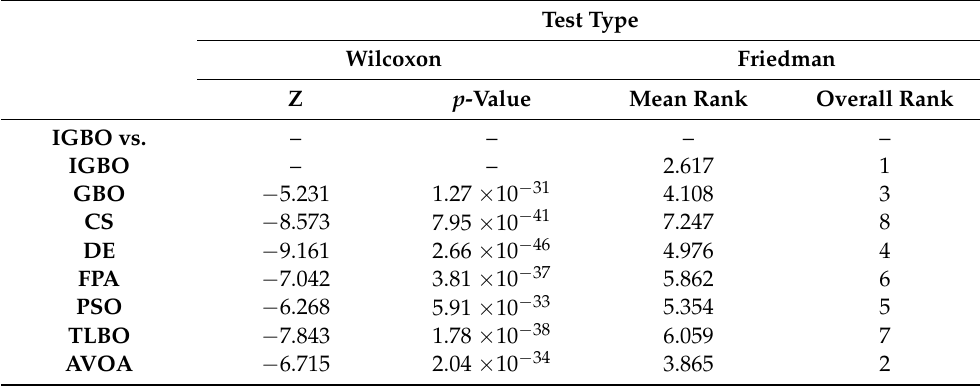
Table 12. Wilcoxon and Friedman tests for I-beam